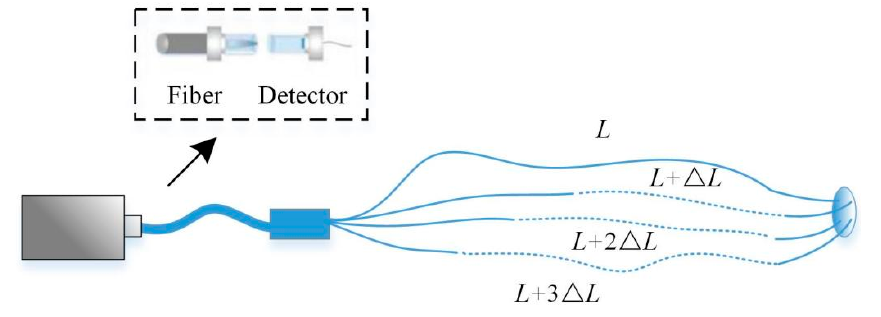
Figure 5. Connection structure diagram of fiber array and detector array.